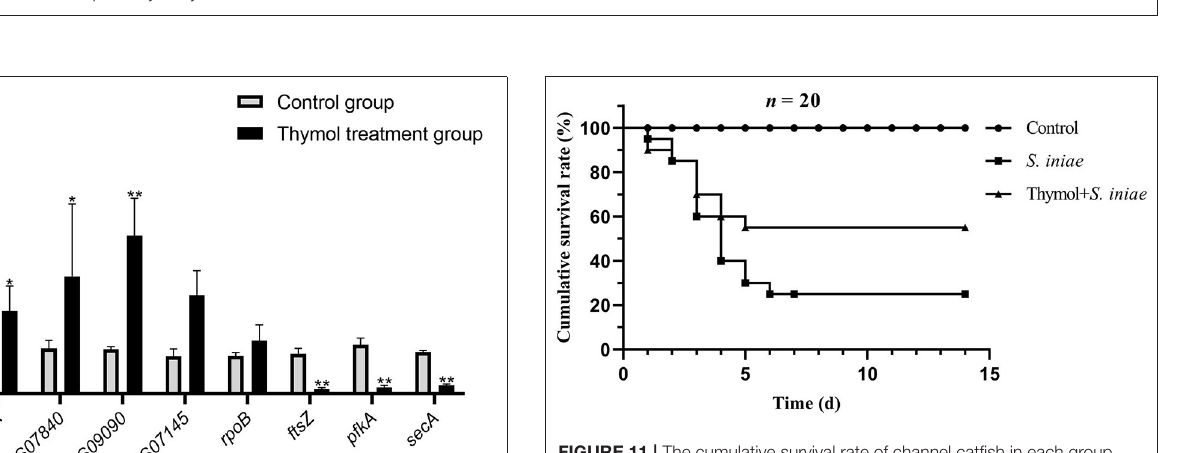
by electron microscopy, nucleotides and proteins changes, and